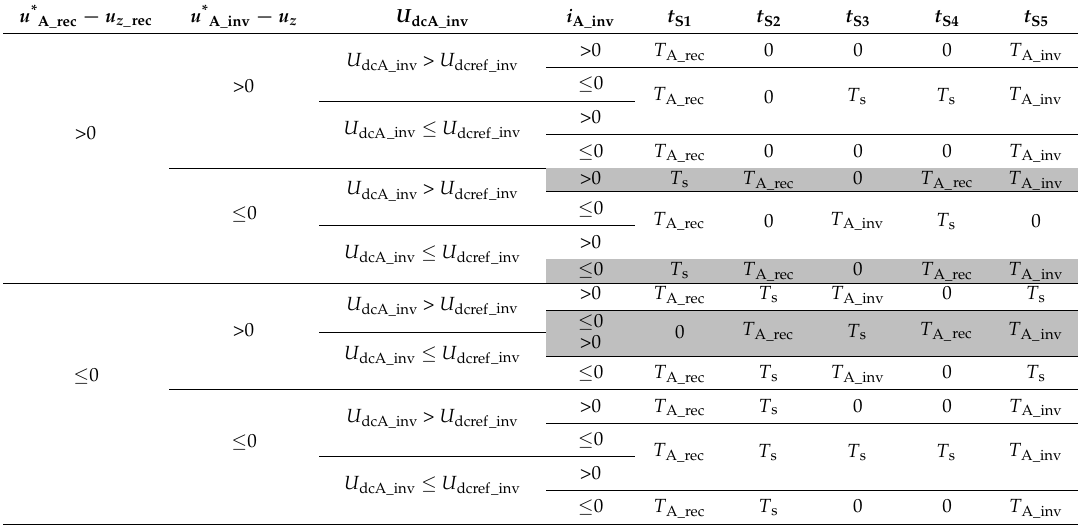
Table 5. Switching states of rectifier side and inverter